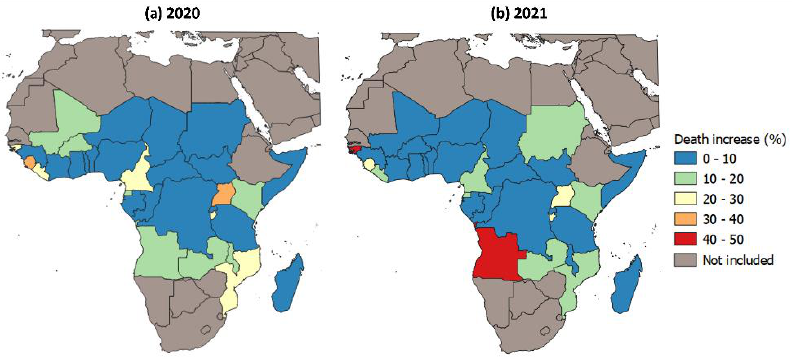
Figure 4. Estimated national level % mean increase in malaria mortality in the study region brought upon by disruptions in malaria case management in ( a ) 2020 and ( b ) 2021.